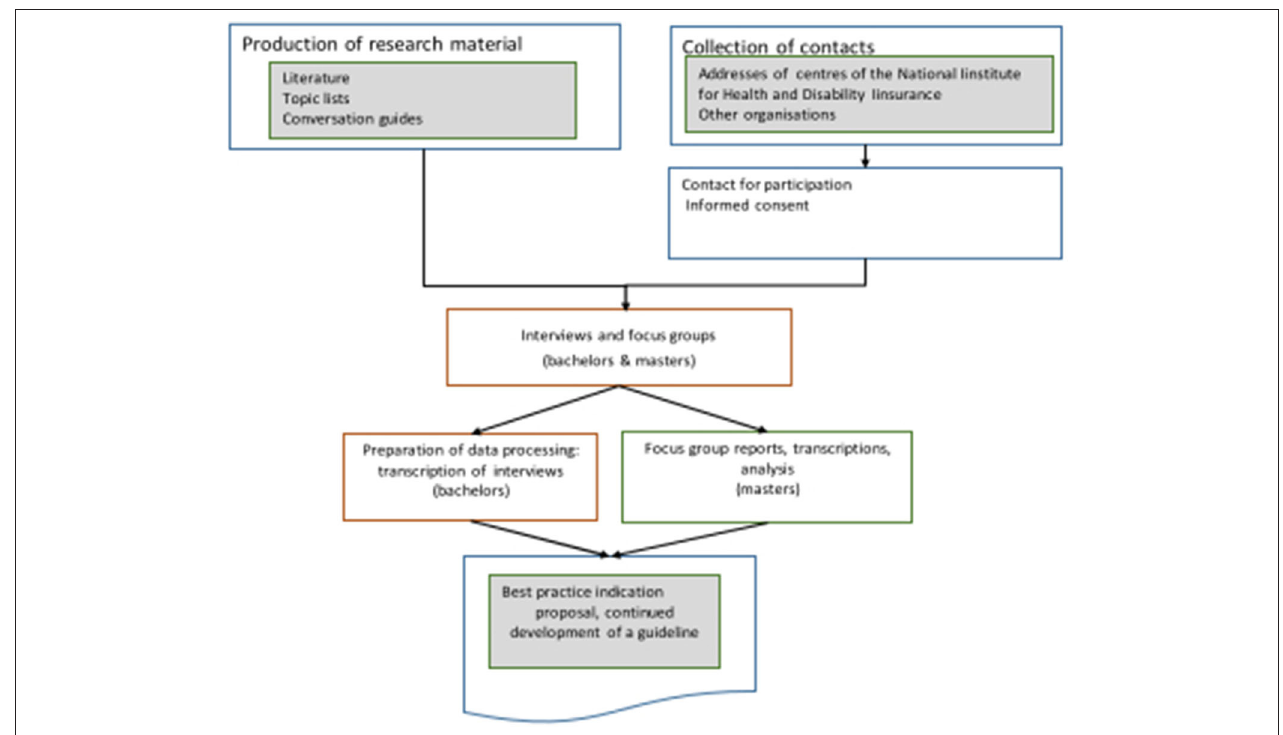
FIGURE 1 | Practice-based evidence: research